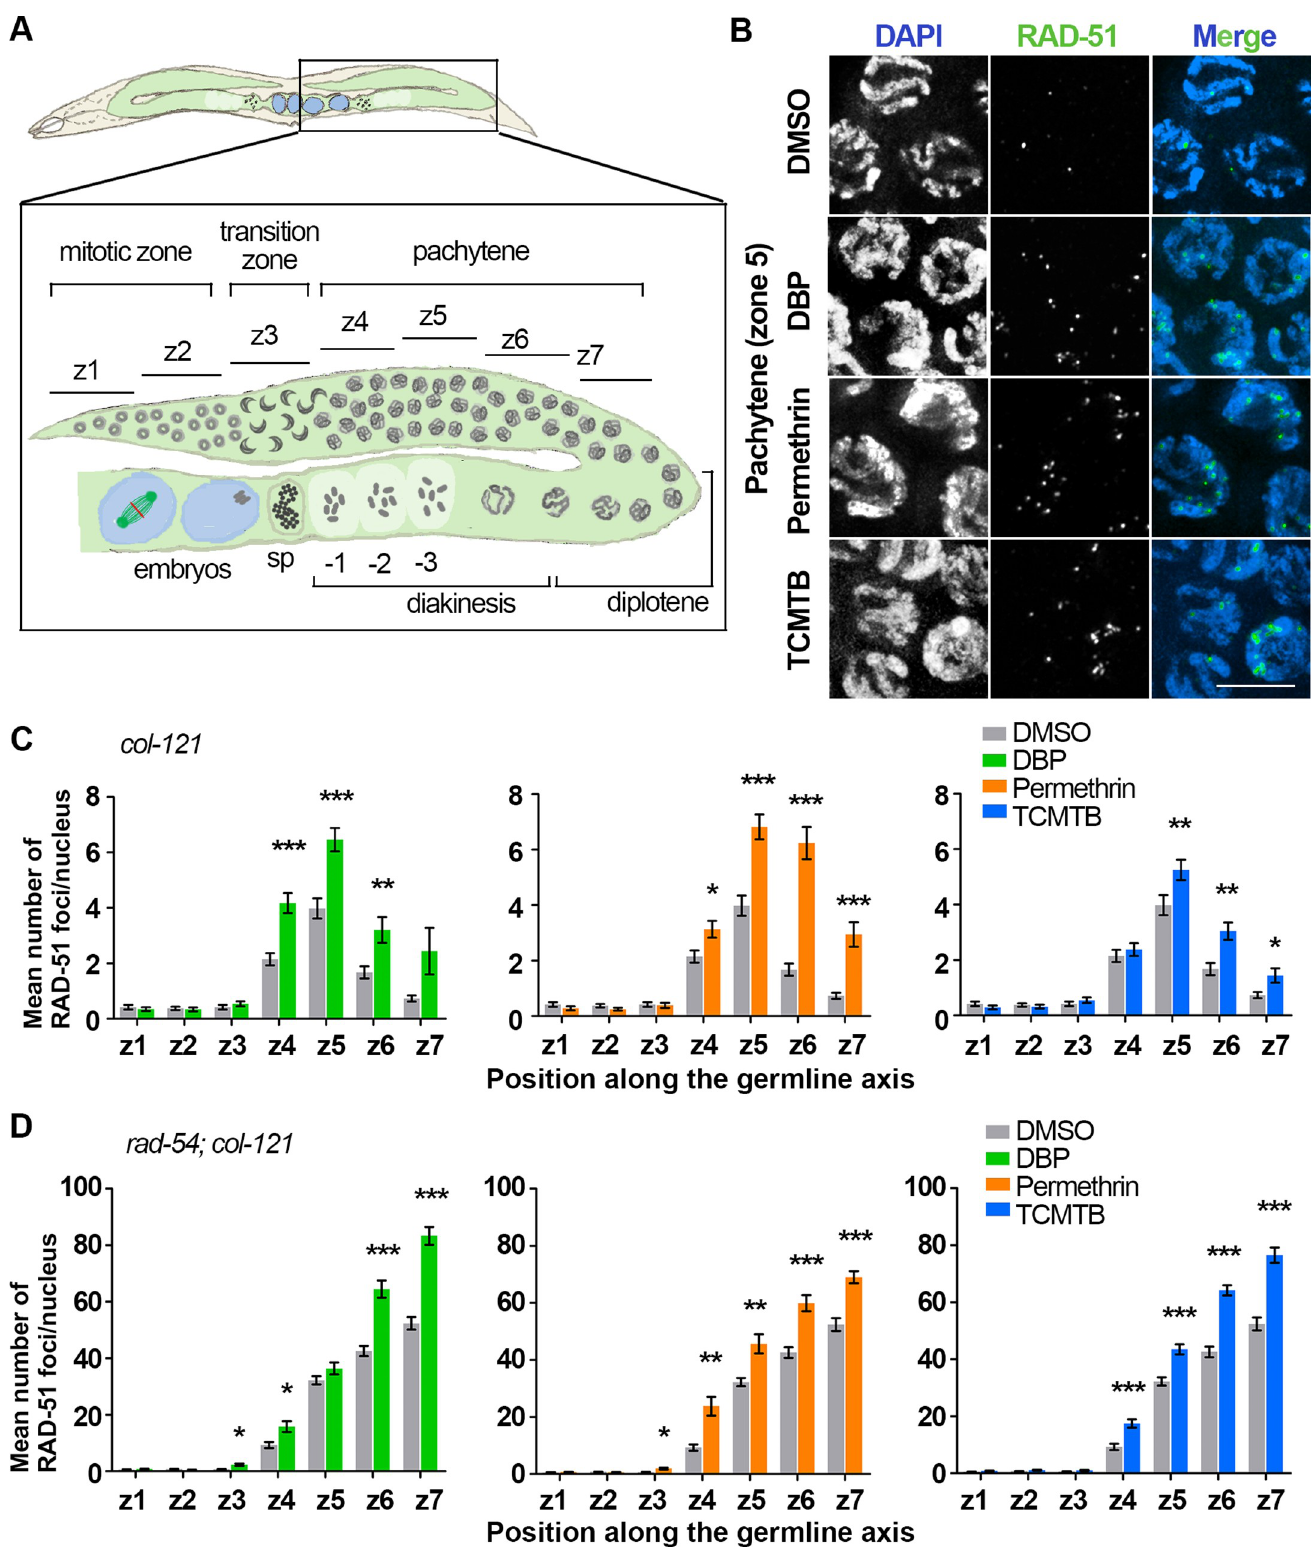
Fig 4. Chemical exposures result in increased DSB formation and impaired DSB repair. (A) Schematic representation of a C . elegans germline indicating the position of the equally sized zones (z1-z7) scored for RAD-51 foci. Nuclei in z1 and z2 are undergoing mitosis. They enter meiosis at z3 when they enter the transition zone, which corresponds to the leptotene/zygotene stages. Nuclei then proceed through pachytene (z4-z7), diplotene and diakinesis on their way into the